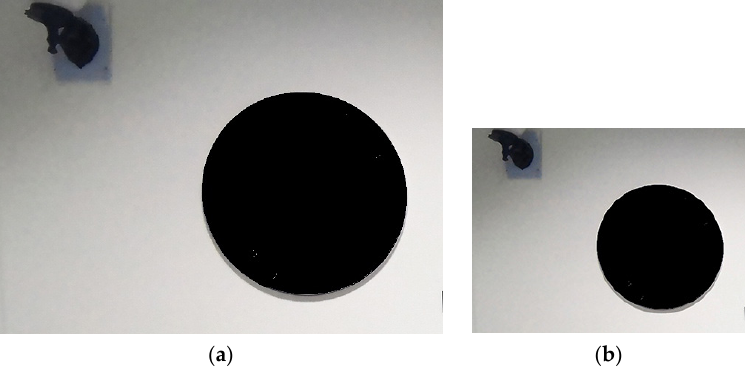
Figure 11. Image preprocessing: ( a ) origin background image; ( b ) preprocessed background image.